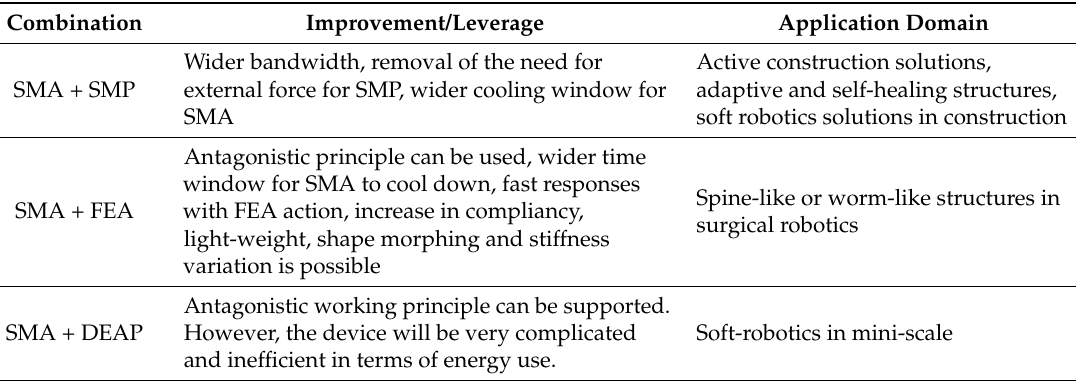
Table 9. Soft and novel actuator combination table for all hybrid